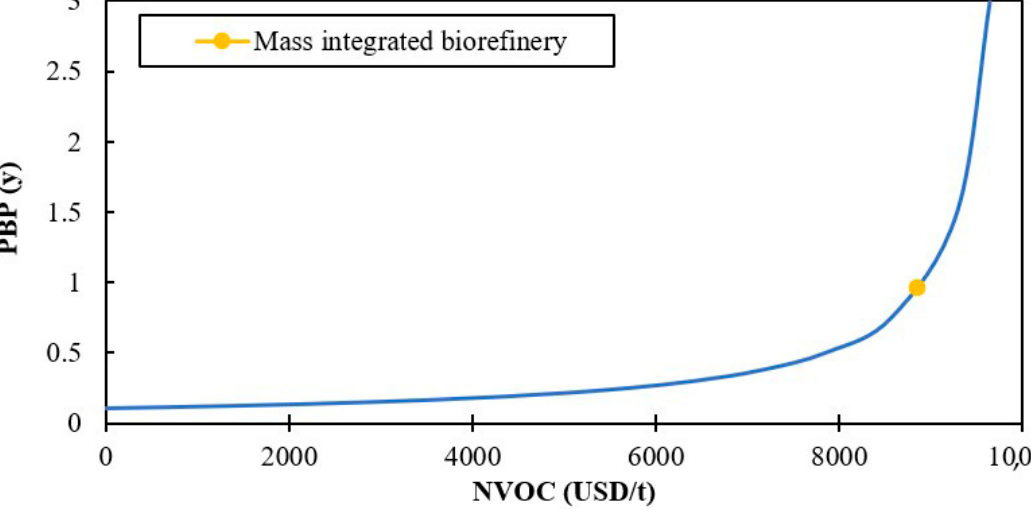
Figure 7. The effect of variable operating cost on the payback period. Figure 7. The e ff ect of variable operating cost on the payback